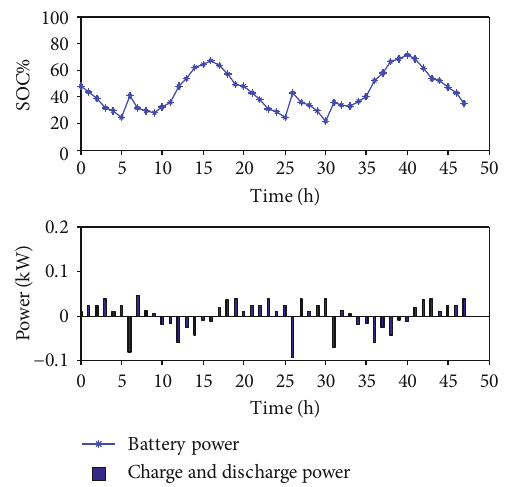
Figure 7: Battery charge state and 48 h charge and discharge power (the BA are charging while power < 0 ; the BA are discharging while power > 0 ).